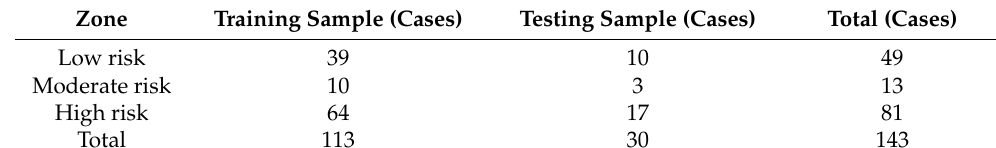
Table 2. Numbers of training and testing samples in the defined risk zones.